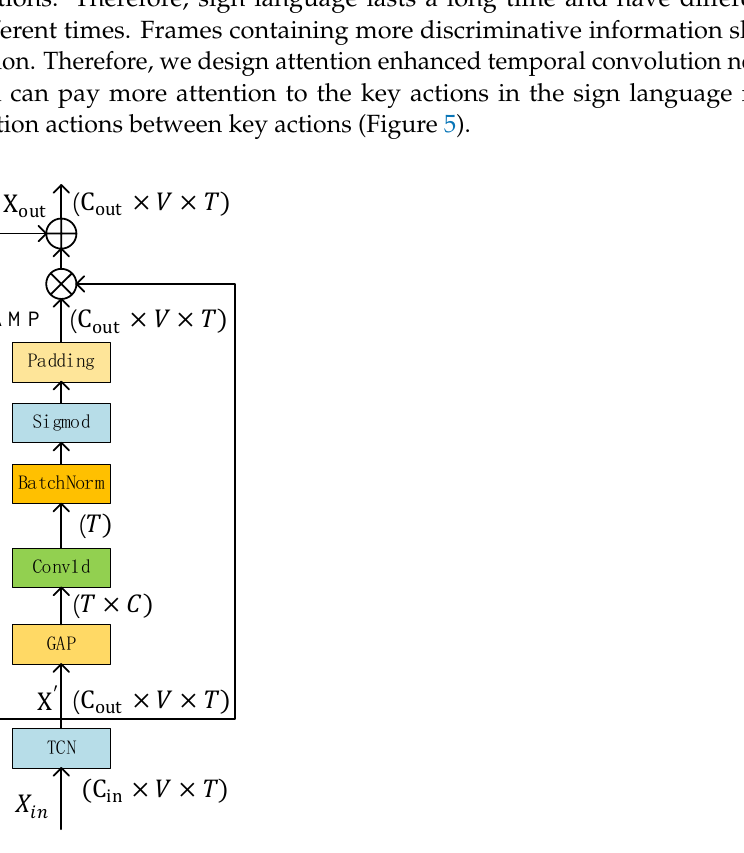
Figure 5. The structure of MSA. AMP means the attention map, which contains attention information of different time.